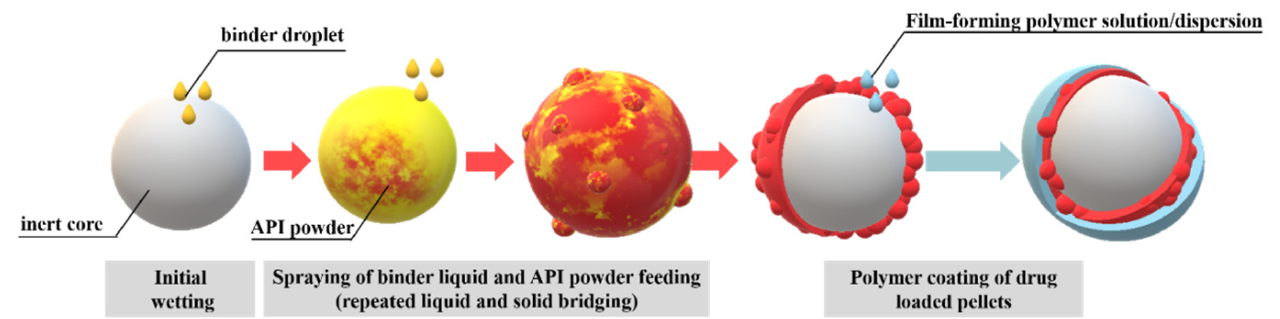
Figure 3. Schematic illustration of dry powder layering of starter core and polymer coating.